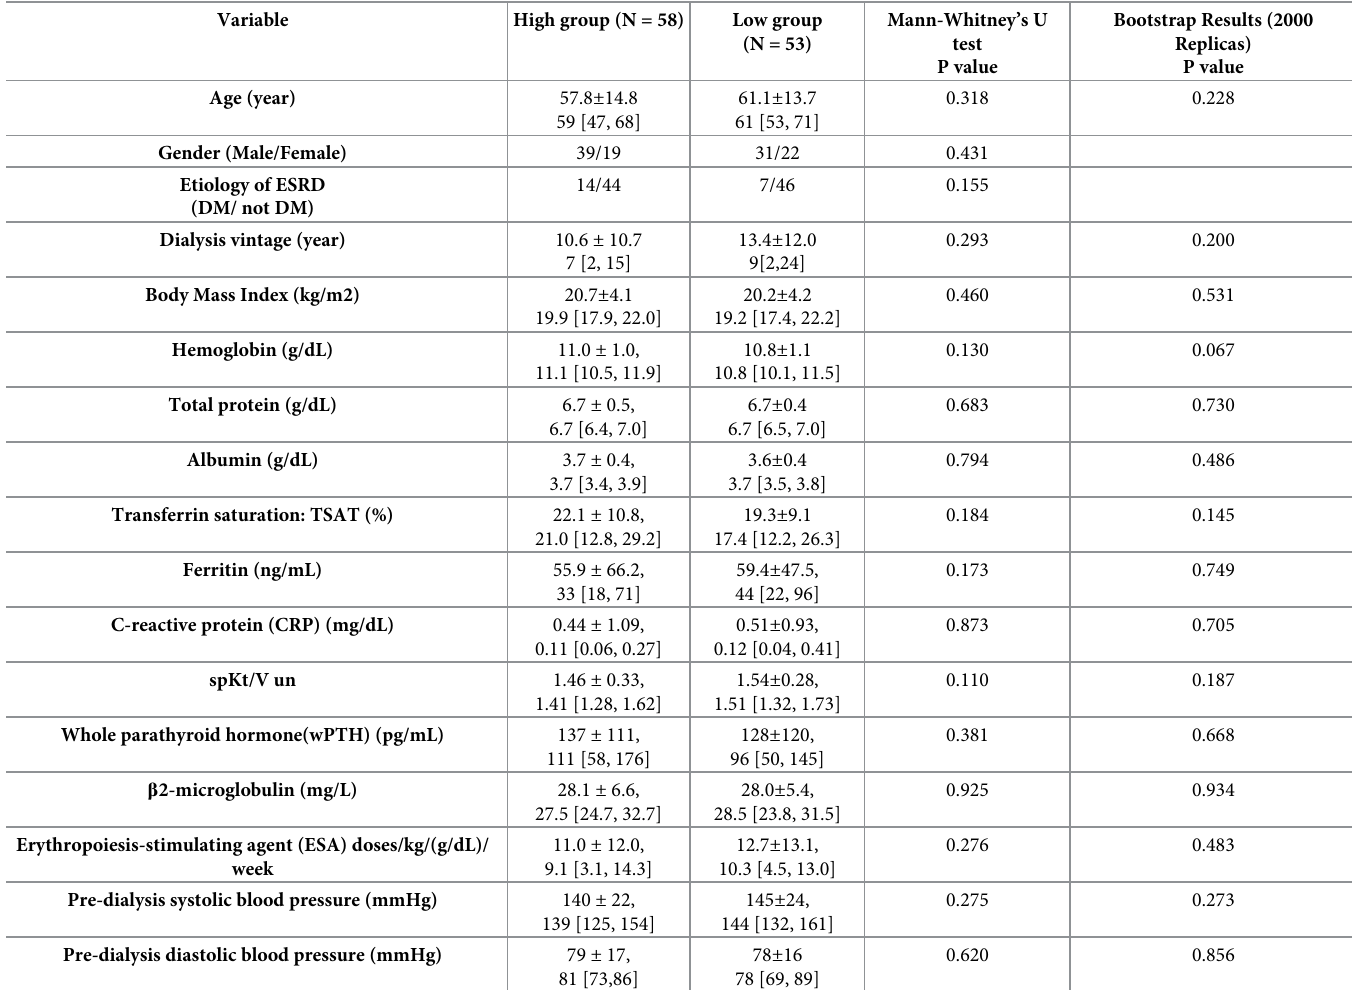
Table 5. Clinical characteristics of the high and low